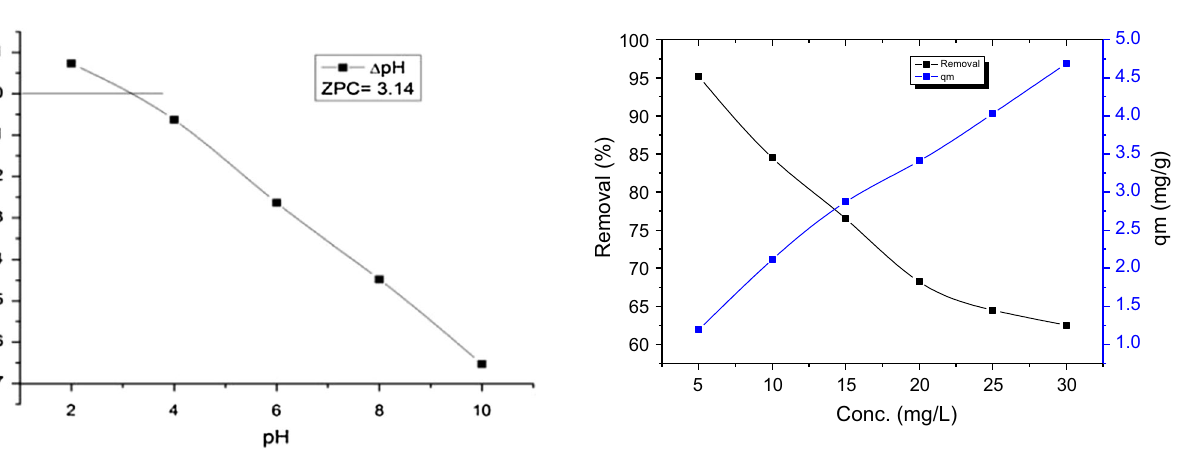
Fig. 4 pH ZPC of mosambi peel dust